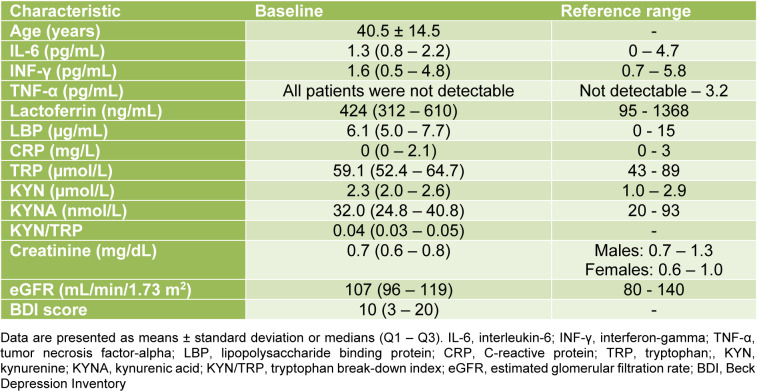
Baseline characteristics of the study population (n = 251)